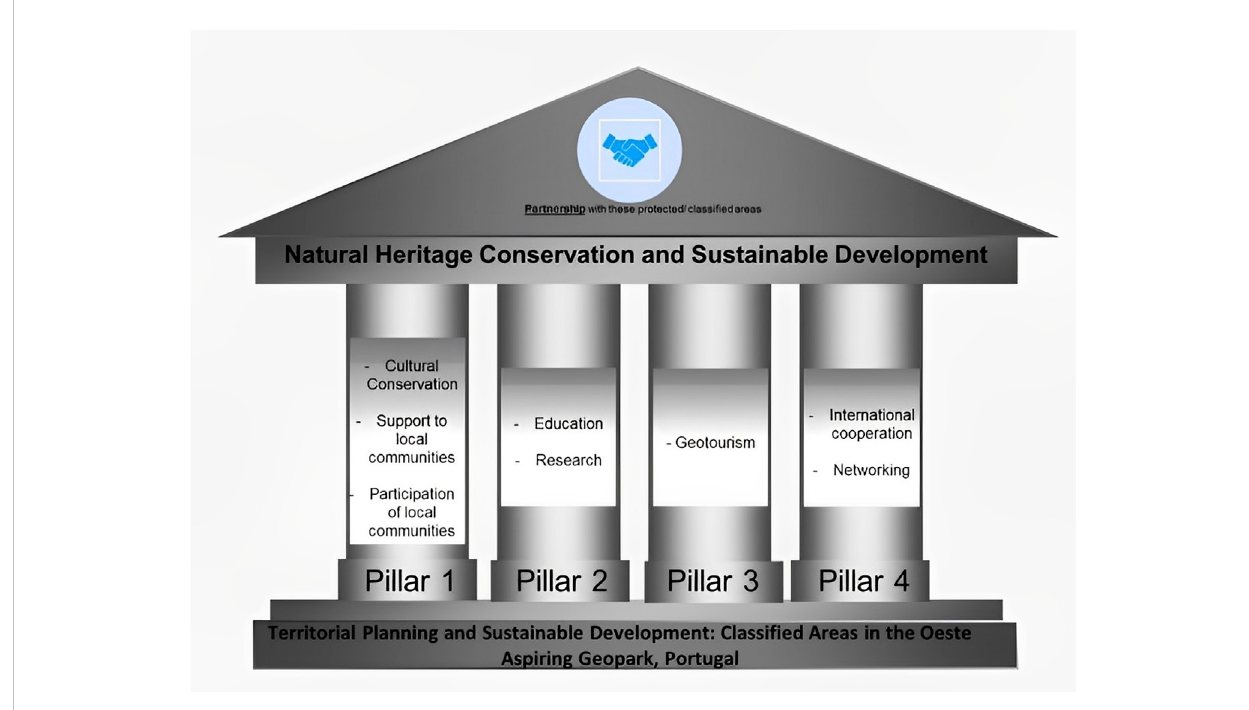
FIGURE 11 Pillars for joint action between classi fi ed areas in the aGO territory. Source: produced by the